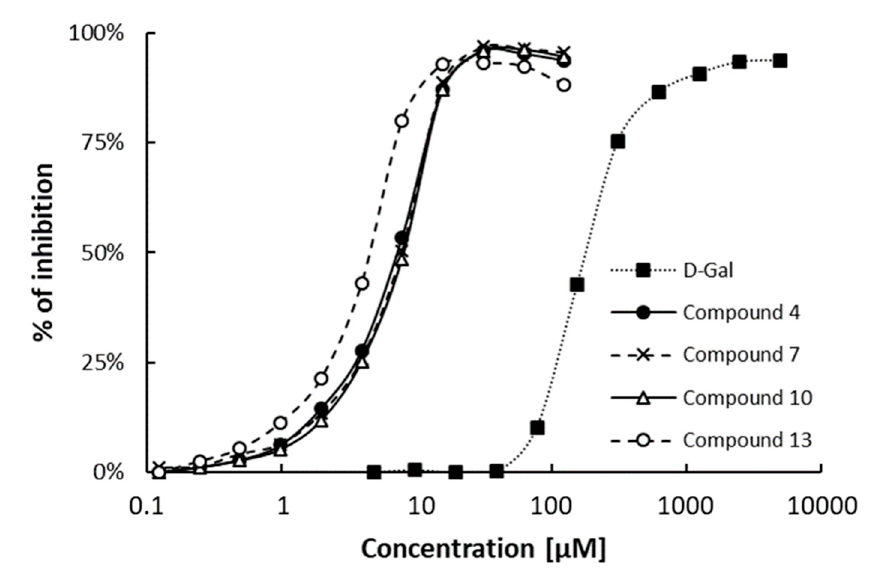
Figure 3. Inhibitory effects of tested compounds on lectin PA-IL binding to immobilized D -galactosides obtained by SPR. Individual type of line corresponds to monovalent (dotted), trivalent (solid) and tetravalent (dashed) ligands. D -galactose was used as a control and standard.